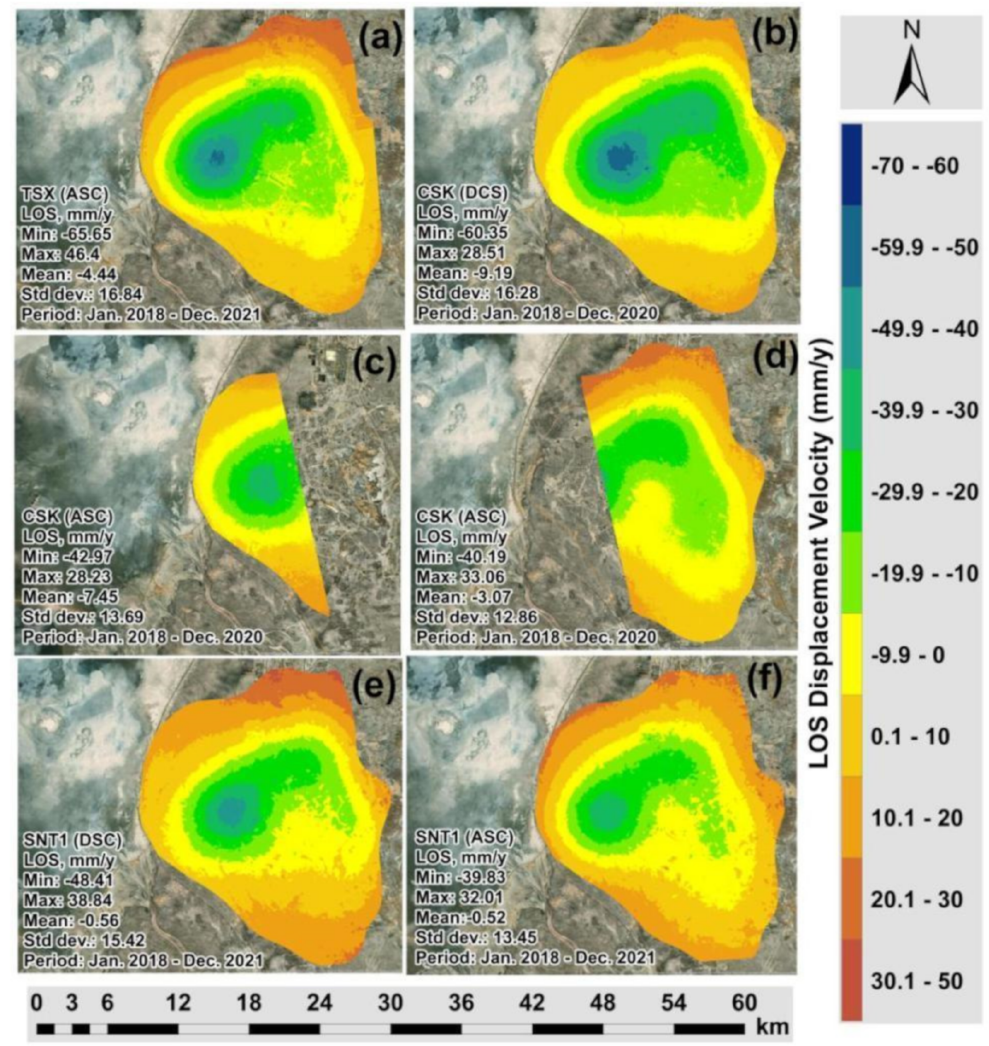
Figure 6. Maps of LOS vertical displacement velocity of the Tengiz oilfield derived from: ( a ) TSX (ASC Track); ( b ) CSK (DSC Track); ( c ) CSK (ASC Track 1); ( d ) CSK (ASC Track 2); ( e ) SNT1 (DSC Track); ( f ) SNT1